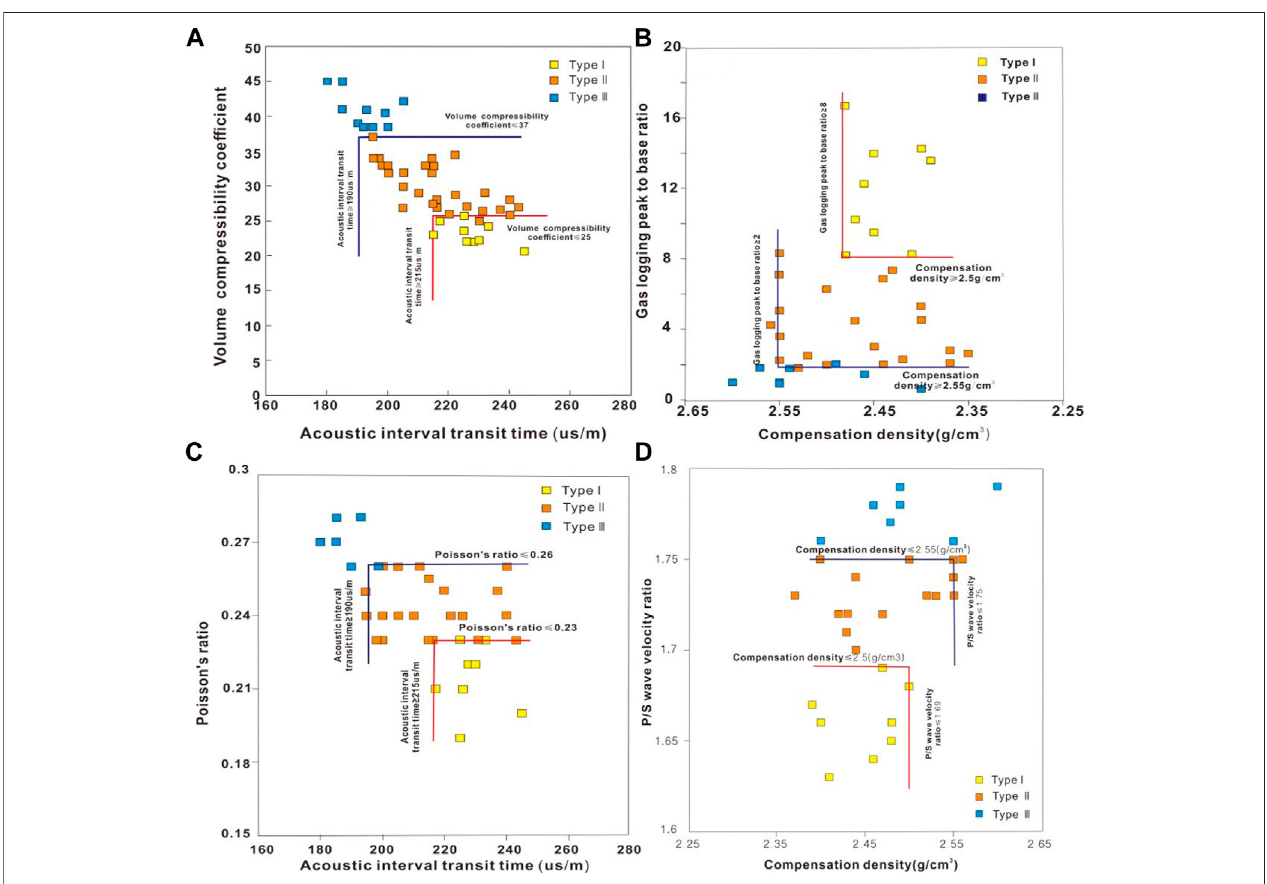
FIGURE 12 | Classi fi cation and identi fi cation chart of effective reservoir logging in the Wangfu gas fi eld. Note: (A) Crossplot of the acoustic time difference and volume compressibility coef fi cient. (B) Compensated density-gas logging peak to base ratio crossplot. (C) Acoustic interval transit time Poisson ’ s ratio crossplot. (D) Compensating density-P/S wave velocity ratio